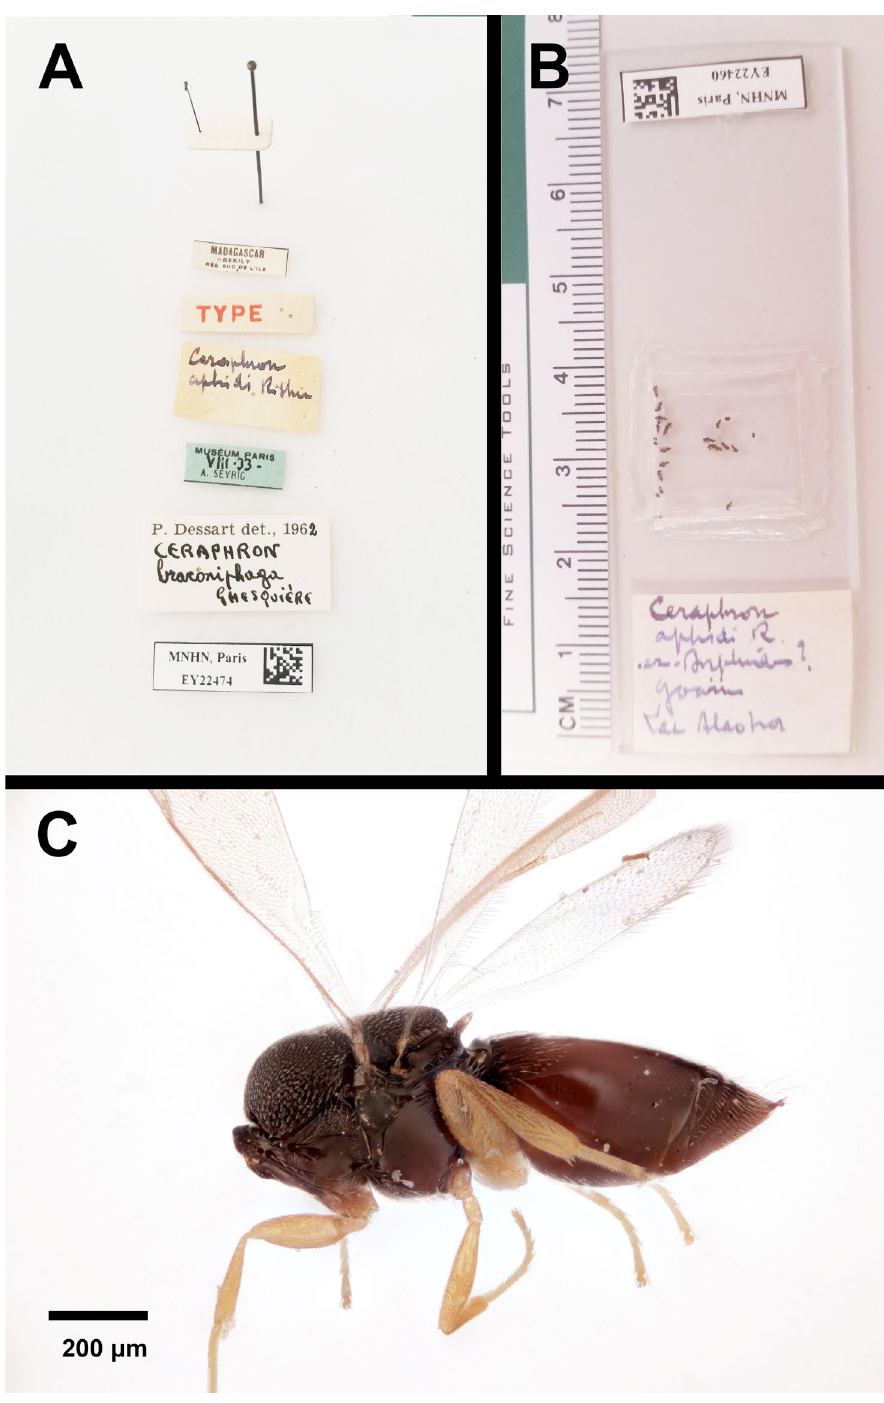
Fig. 26. Ceraphron aphidi (risbec, 1955). A . The double-point mounted syntype female and labels, showing the “TYPE” label (MNhN EY22474). B . One of the lots of specimens labeled as Ceraphron aphidi (risbec, 1955), and mounted on slides in glycerine, presumably by risbec (MNhN EY22460). C . Lateral habitus of the double-point mounted syntype female (MNhN